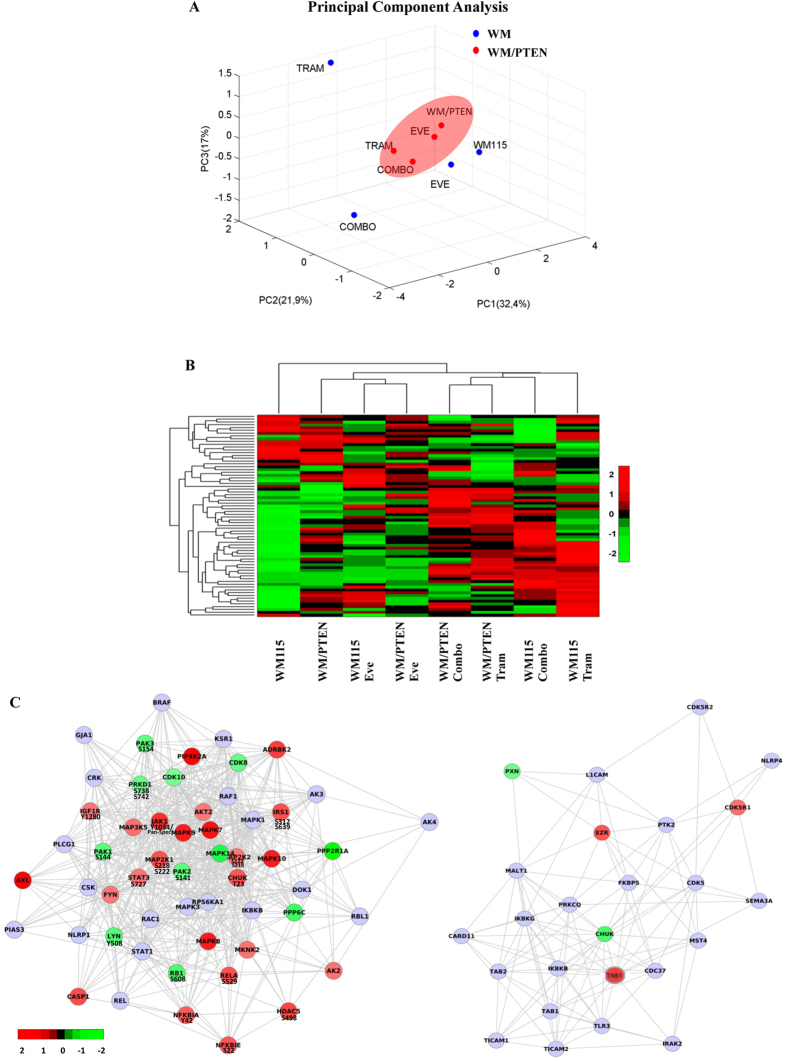
Proteomic analysis of WM115 (PTEN-loss) and WM/PTEN cells subjected to combined MEK and mTOR inhibition.WM115 cells stably transfected with either an empty plasmid vector (WM) or a plasmid encoding a GFP-tagged PTEN (WM/PTEN) were treated with Trametinib (100 nM), Everolimus (100 nM), or Trametinib + Everolimus (Combo) for 24 h. (A) Unsupervised Principal Component Analysis of all proteins deregulated by Trametinib and Everolimus, alone or in combination, in WM115 cells stably transfected with either an empty plasmid vector (WM) or a plasmid encoding a GFP-tagged PTEN (WM/PTEN). (B) Hierarchical Cluster of all deregulated proteins in at least one treatment using Trametinib (Tram), Everolimus (Eve), or the combination of the two drugs (Combo) in WM115and WM/PTEN cells. (C) Interaction network of the proteins found deregulated after combination treatment in WM115 and WM/PTEN. Network analysis was performed using Genemania; the resulting networks were then imported into Cytoscape in order to map fold-change values. Positive and negative fold changes are shown in red and green, respectively, on a scale from +2 to −2.